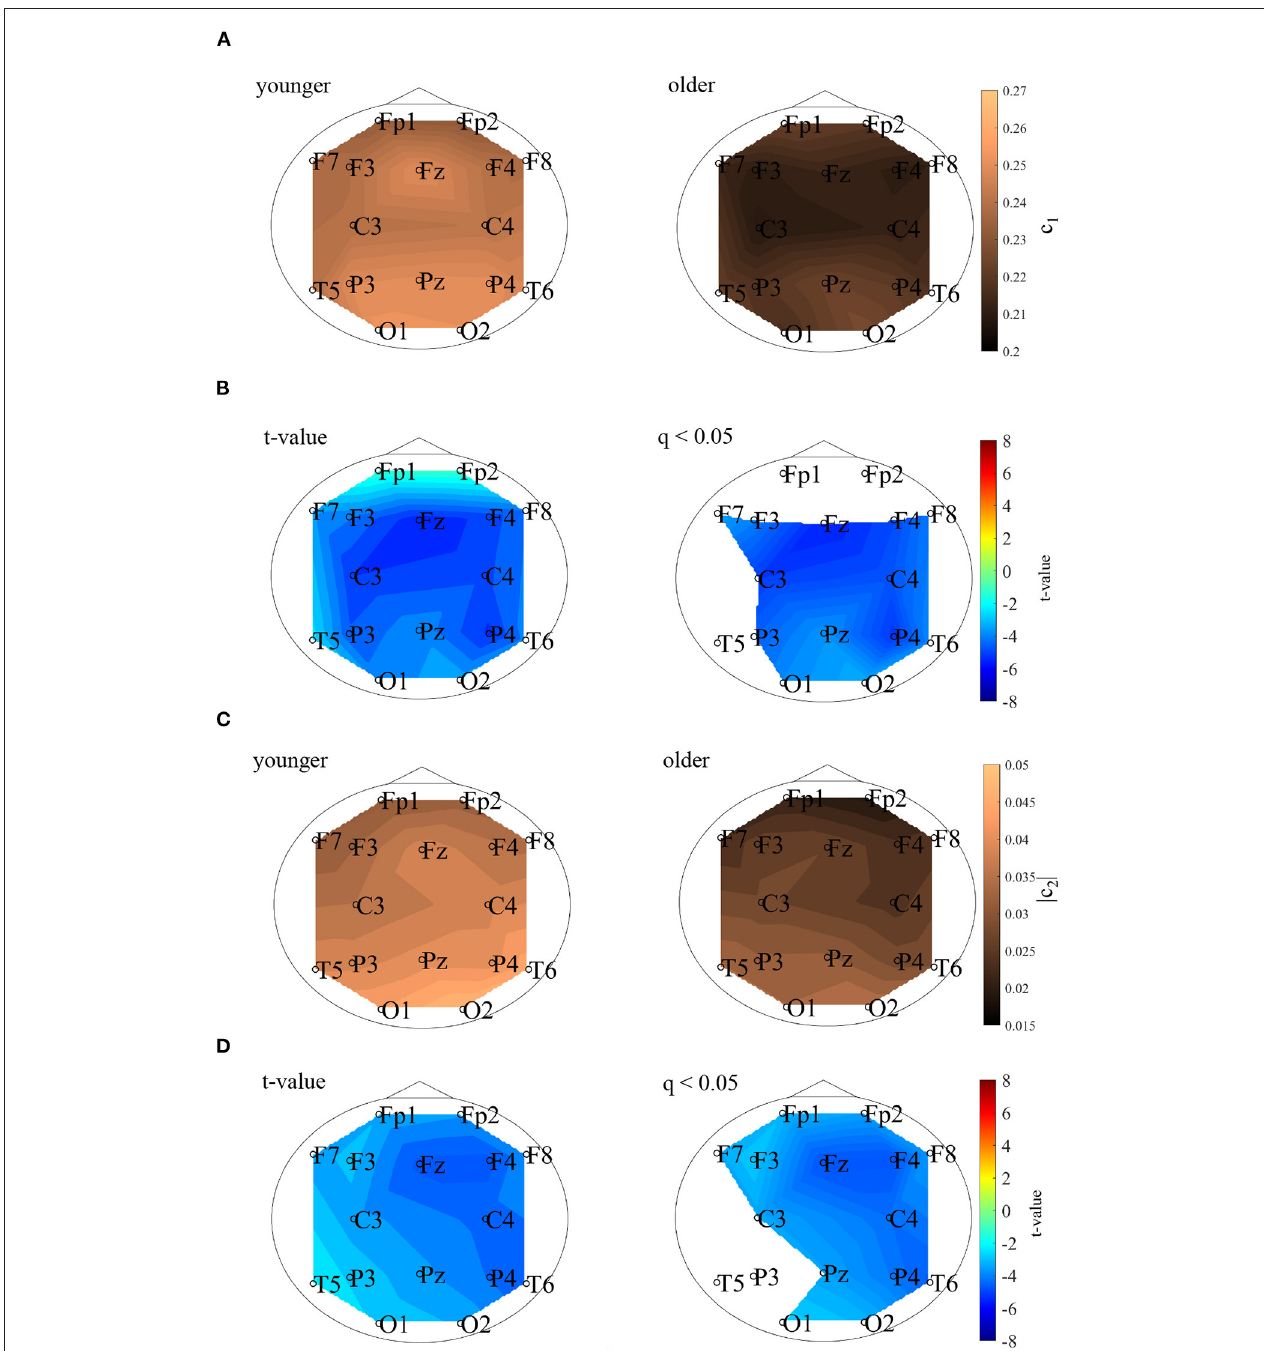
FIGURE 3 | (A) 1st cumulant of the spectrum of singularity c 1 . The mean values of c 1 in the younger (left) and older (right) groups. (B) t values comparing the younger and older groups. Warm (cold) colors represent higher (smaller) c 1 values for older versus younger participants. The left and right of the figure correspond to the t - and t -values satisfying the false discovery rate (FDR) correction criteria q < 0.050. The c 1 value for the older group, which had statistically significantly lower values at F3, Fz, F4, F7, F8, C3, C4, P3, Pz, P4, T6, O1, and O2, and is shown here. (C) Absolute value of 2nd cumulant of the spectrum of singularity | c 2 | . The mean values of | c 2 | in the younger (left) and older (right) groups are shown here. (D) t -values comparing the older and younger groups. Warm (cold) colors represent higher (smaller) | c 2 | values for older versus younger participants. The left and right correspond to the t - and t -values satisfying the FDR correction criteria q < 0.050. The | c 2 | of the older group had statistically significantly lower values at Fp1, Fp2, F3, Fz, F4, F7, F8, C3, C4, Pz, P4, T6, O1, and O2.